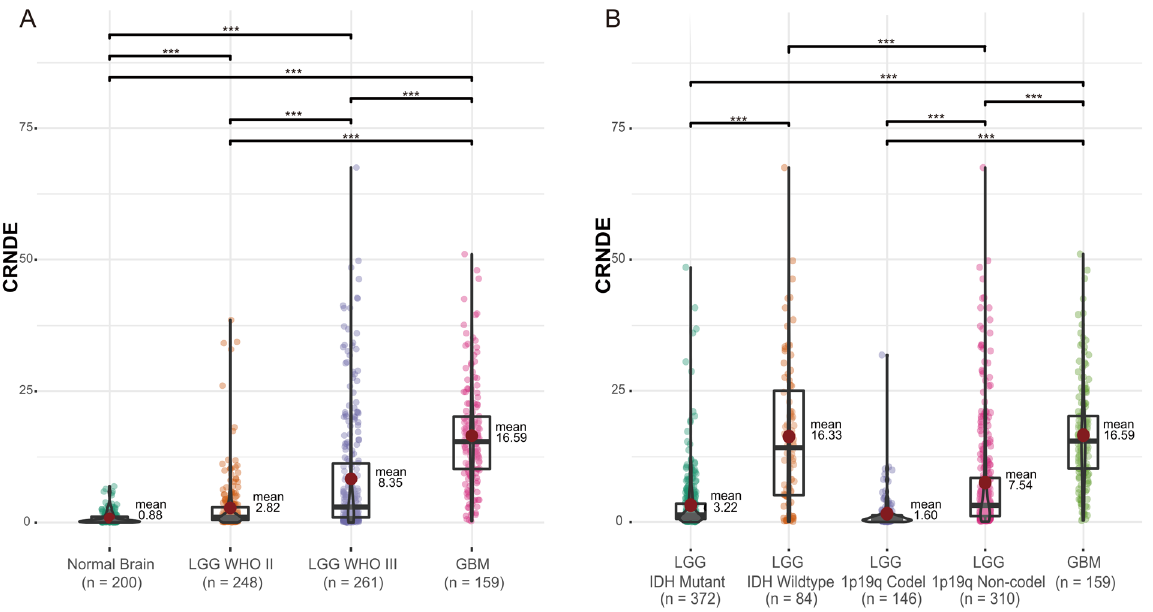
Figure 1. The expression of CRNDE in gliomas of different ( A ) grades and ( B ) molecular subtypes (*** p < 0.001).